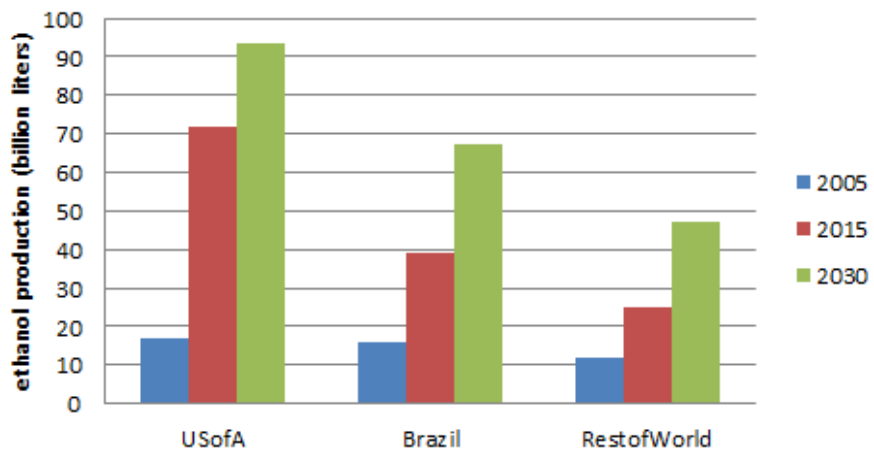
Figure 9. Ethanol production in major regions under baseline.